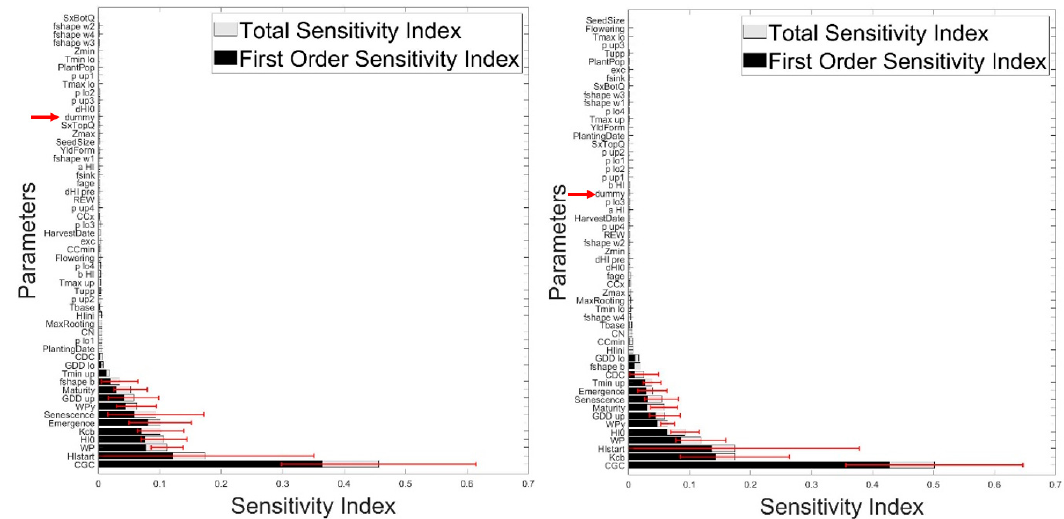
Figure 4. Average sensitivity indices using the EFAST method Maccarese (left) and Xiaotangshan (right) test sites. The error bars in red represent the extreme values of total-order sensitivity indices. The dummy parameter is highlighted with the red arrow.